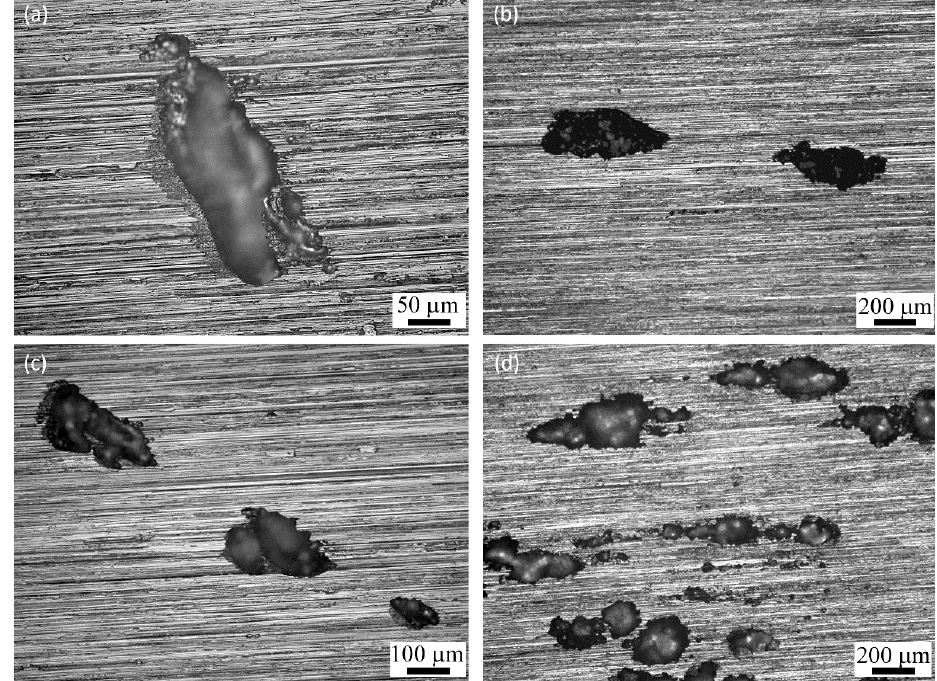
Figure 9. Surface optical images of the surface after 1000 s of Galvanostatic test in 3.5% sodium chloride aqueous solution for ( a ) annealed ( b ) 207 MPa ( c ) 310 MPa ( d ) 460 MPa.